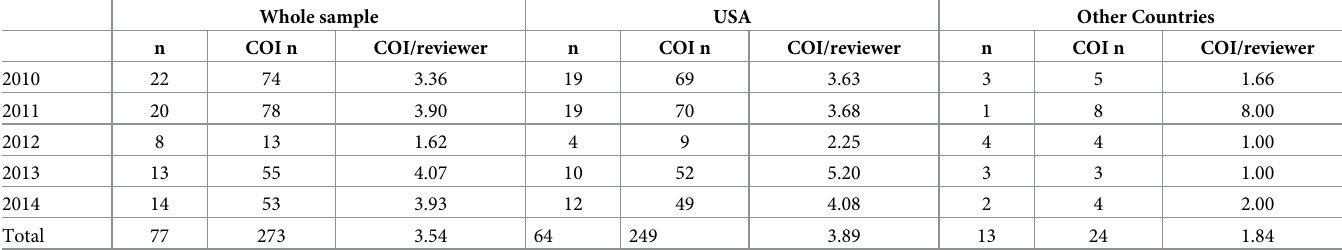
Table 2. Number of potential COI and COI/authors ratio per year.